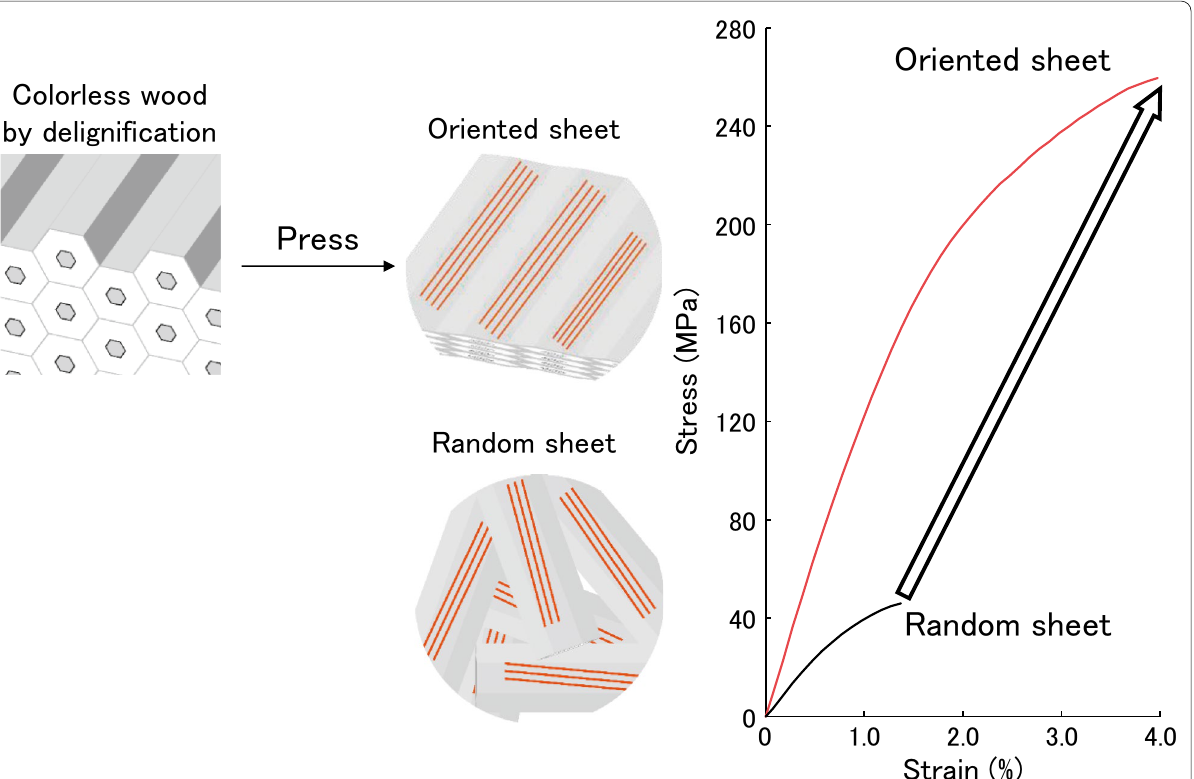
Fig. 2 Tensile stress–strain curves for an oriented sheet and a random sheet prepared by pressing colorless wood (reproduced from